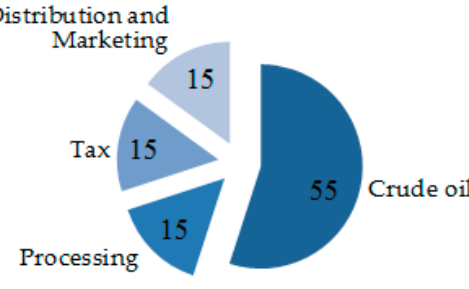
Figure 4. Typical price structure for diesel fuel.